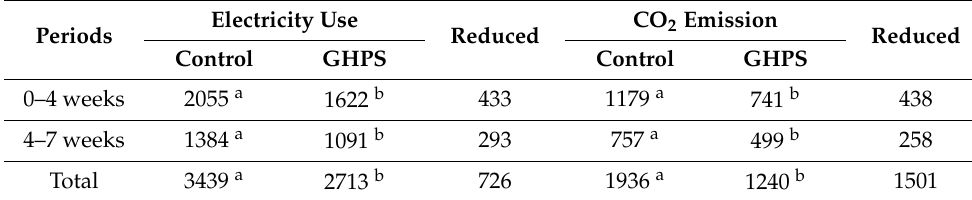
Table 3. Effect of the combined geothermal and solar heating system (GHPS) on electricity consumption (kWh) and CO 2 concentration (kg).